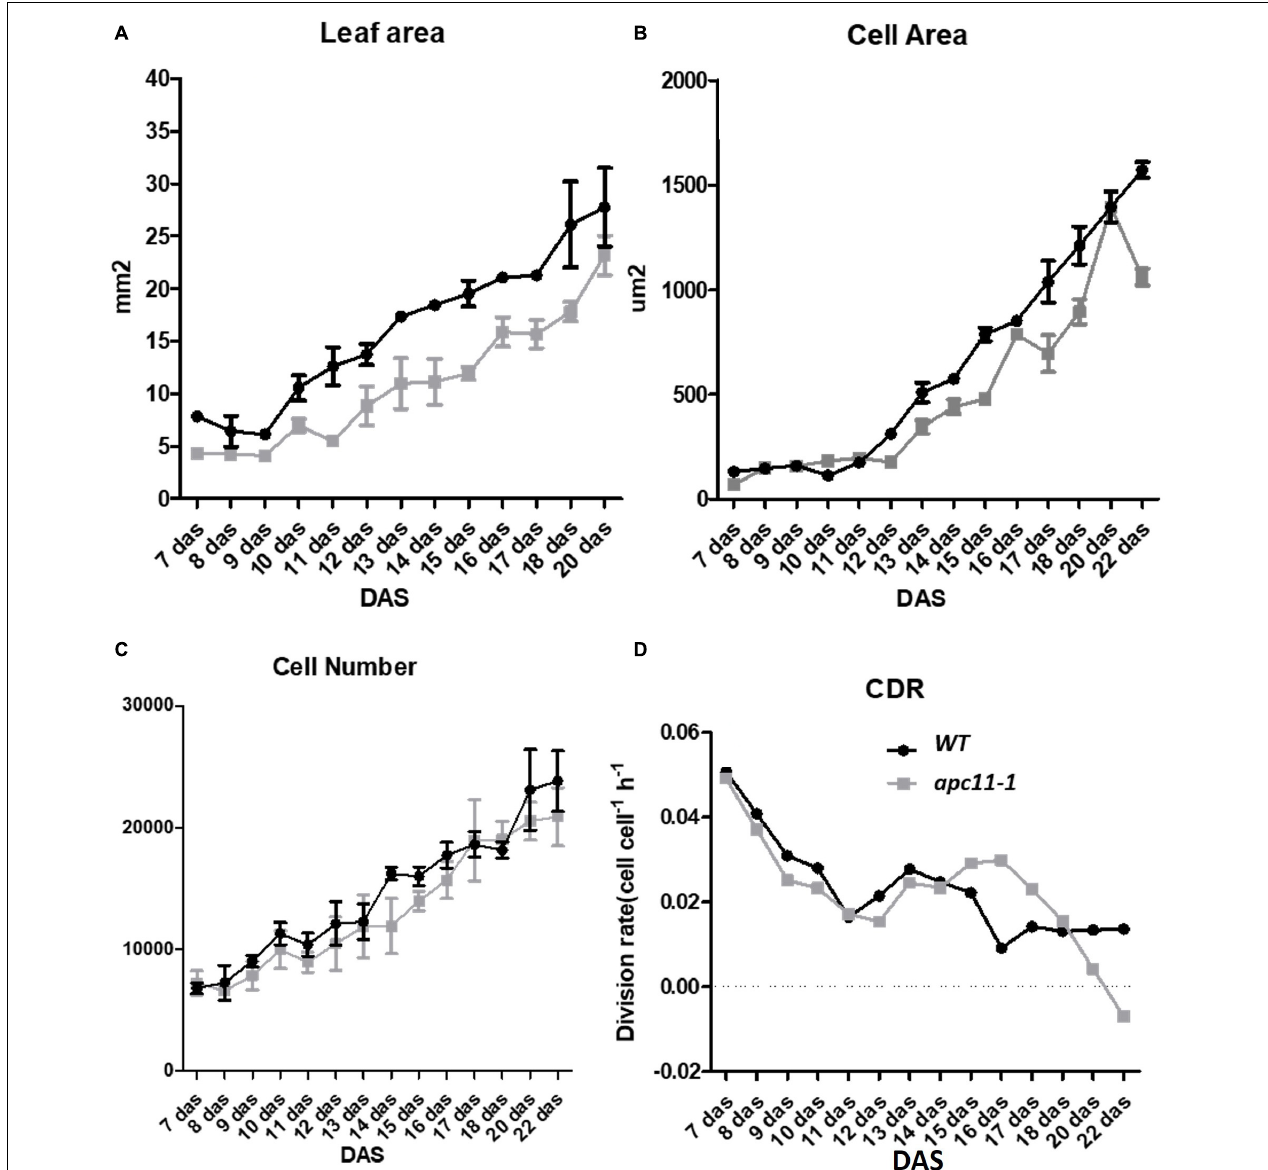
FIGURE 5 | Kinematics analysis of apc11-1 (gray square) and WT (black circle) plants grown in vitro . (A) Leaf blade area. (B) Cell area. (C) Cell number quantification on the abaxial side of the leaves. (D) Cell division rate